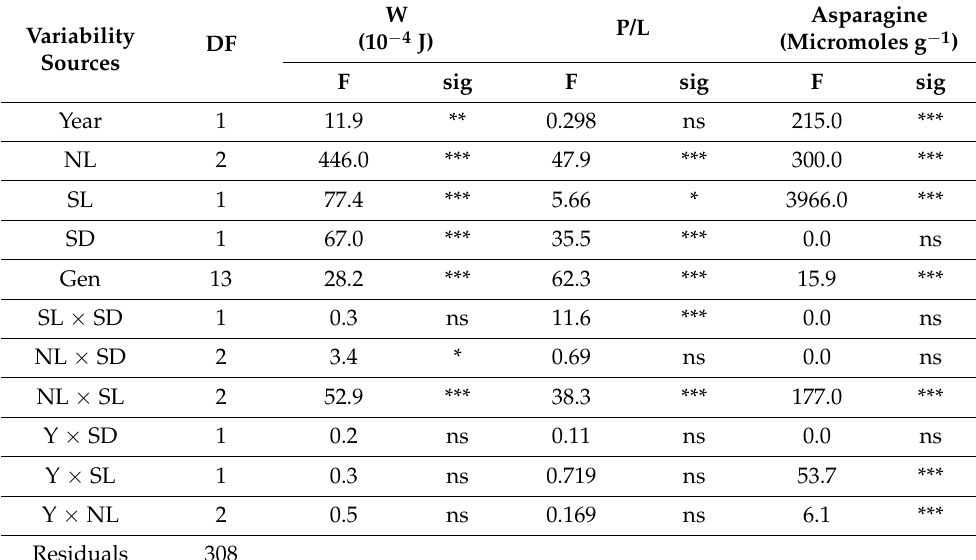
Table 5. Results of the ANOVA for dough strength (W), the ratio between dough tenacity and dough extensibility (P/L), and ASN concentration in whole flour. The table columns report the Fisher F (F) and the significance levels: * = 0.05, ** = 0.01, *** = 0.001, ns = not